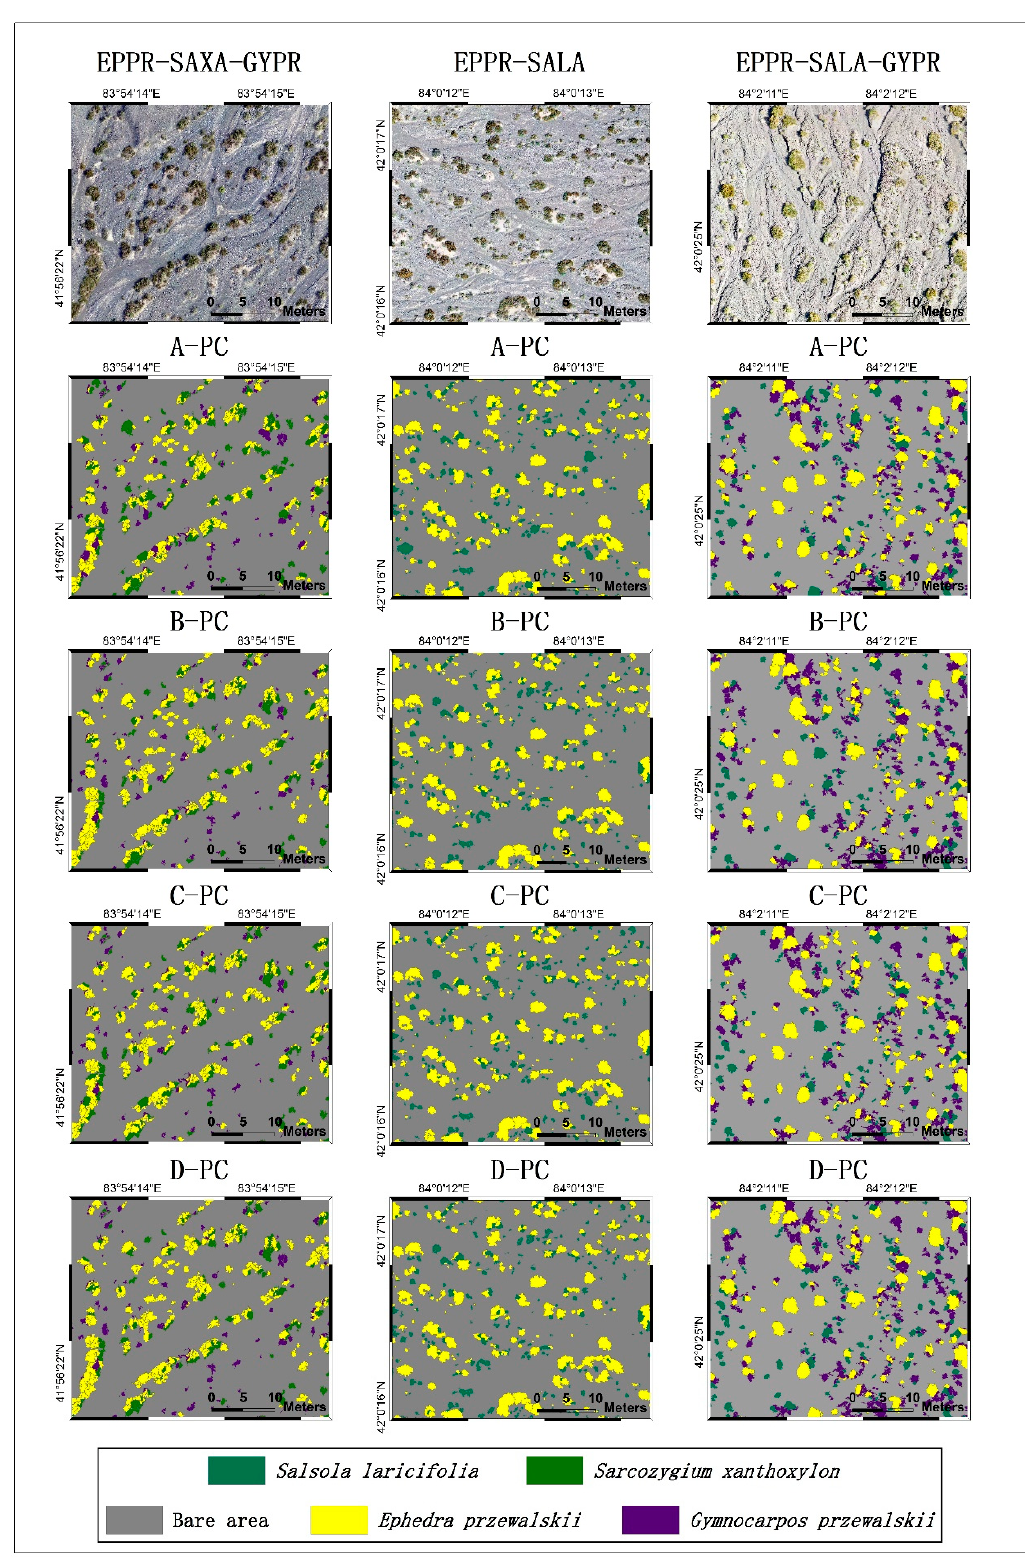
Figure 7. Unmanned aerial vehicle (UAV) RGB image of the three shrub vegetation alliances (EPPR–SAXA–GYPR; EPPR– SALA; and EPPR–SALA–GYPR) and the corresponding prediction results for the four sets of variables (A-PC, B-PC, C-PC, and D-PC) generated by the random forest (RF) model.